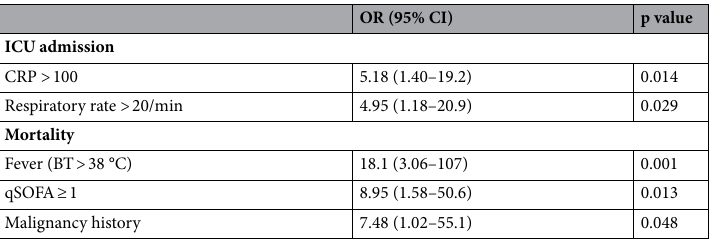
Table 4. Analysis of predictive factors for ICU admission and mortality using multivariate logistic regressions with stepwise selection. The threashold for inclusion were variables with a significance level of less than 0.1 in univariate analysis.